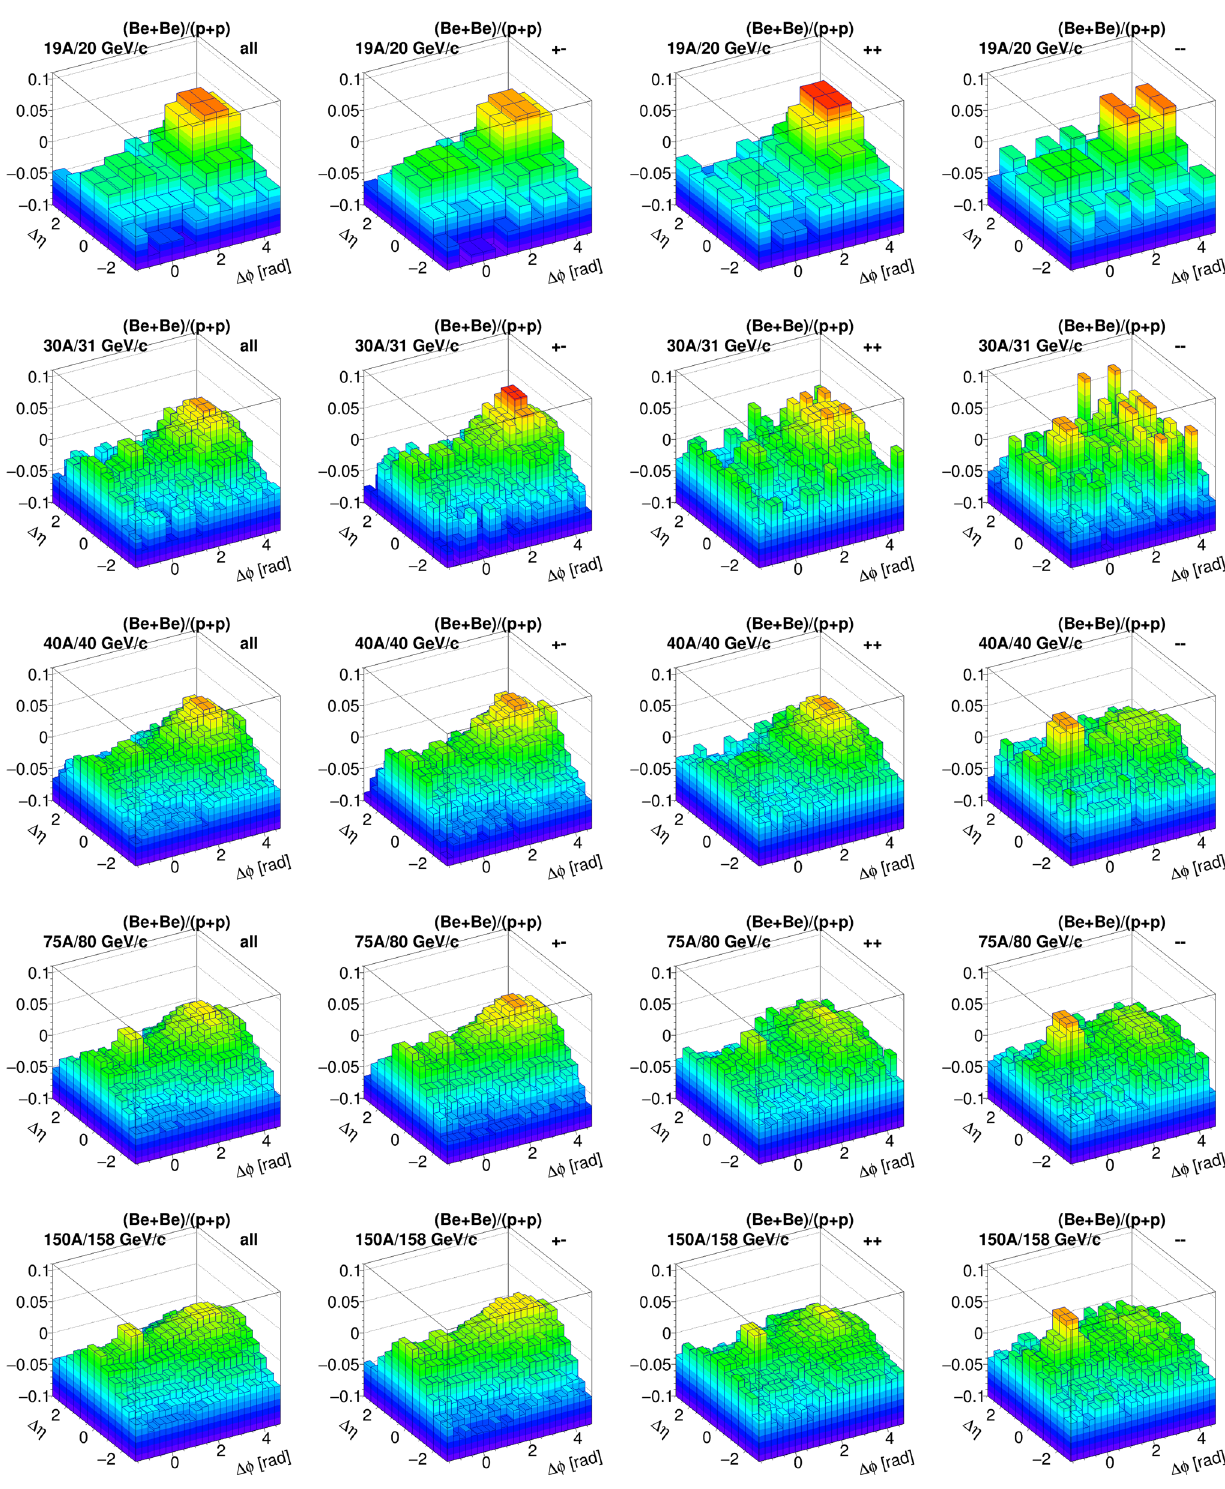
Fig. 11 Ratio R BeBe pp for all pair combinations and momenta (follow- ing formula Eq. 4). Each row shows different beam momentum (beam momentum increases downwards). Every column presents results for